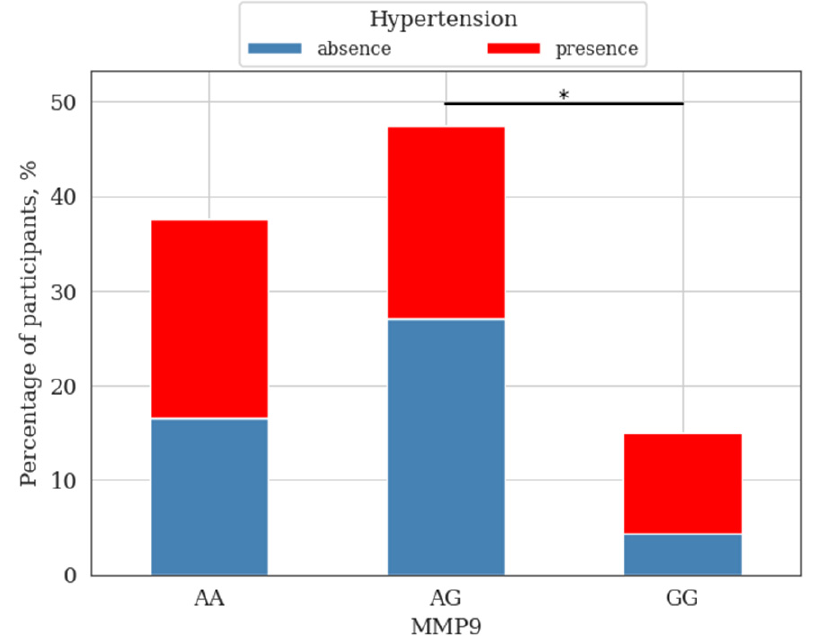
Figure 3. The presence of hypertension in the study group of individuals depending on the genotypes of the polymorphism rs17576 of the MMP9 gene; *—differences were considered significant at a corrected p -value ( p ) < 0.05 ( χ 2 test, post-hoc pairwise χ 2 test Benjamini–Hochberg FDR correction). When studying other indicators associated with the vascular wall, no significant differences between the genotypes of the rs17576 polymorphism of the MMP9 gene were found (Figures